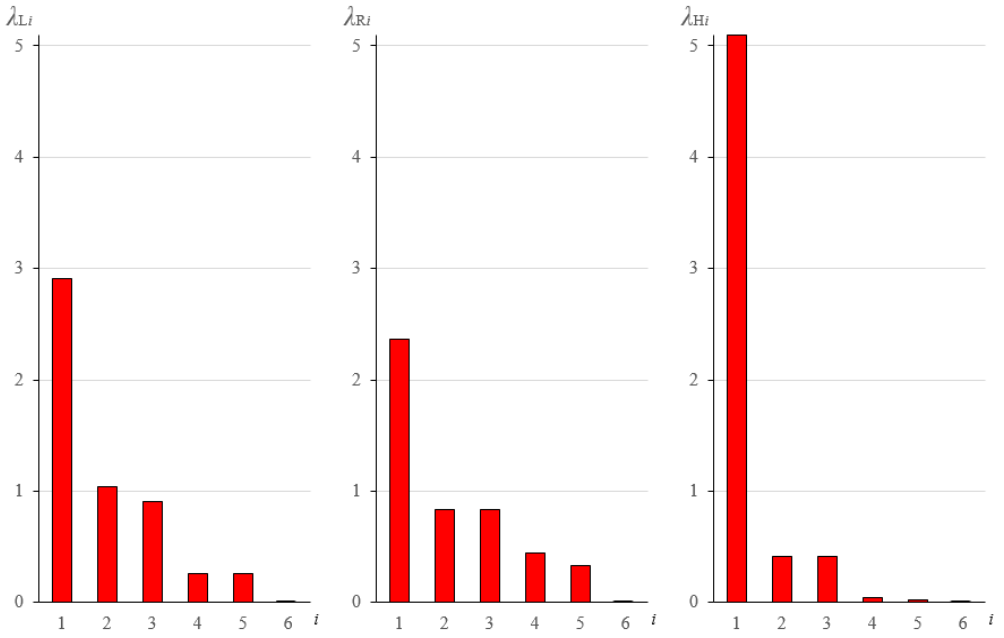
Figure 6. Distribution of eigenvalues for (L), (R) and (H) metamaterials.